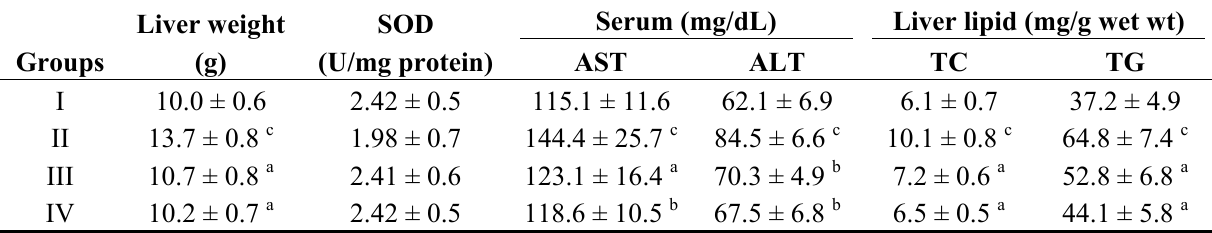
Table 4. Effects of A. capillaris extracts on HFD-induced fatty liver.